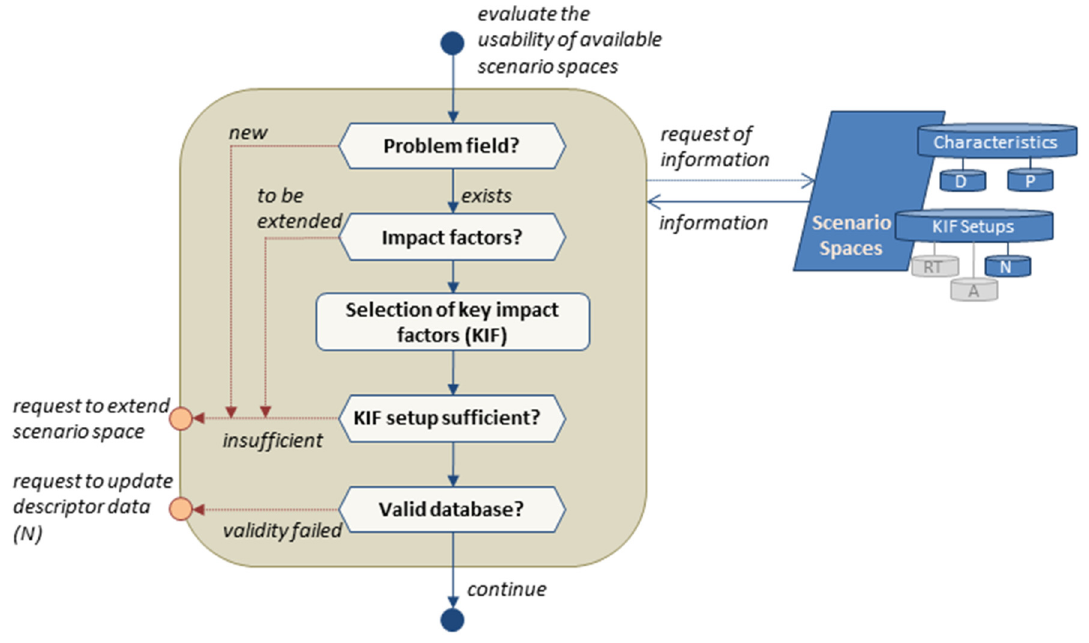
Figure 4. Flow chart of scenario space evaluation as a function of context specification.